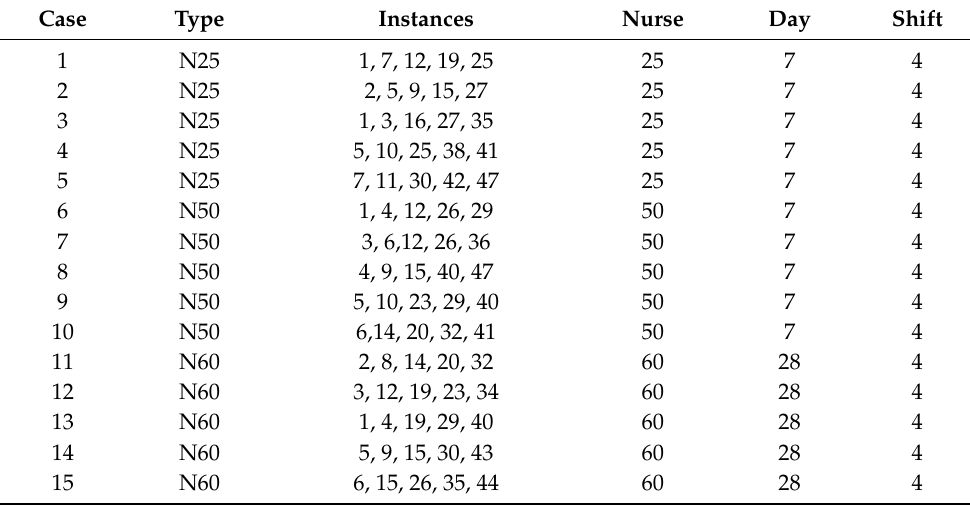
Table 1. Instances Taken from dataset with the values of Nurse, Day, and Shift.